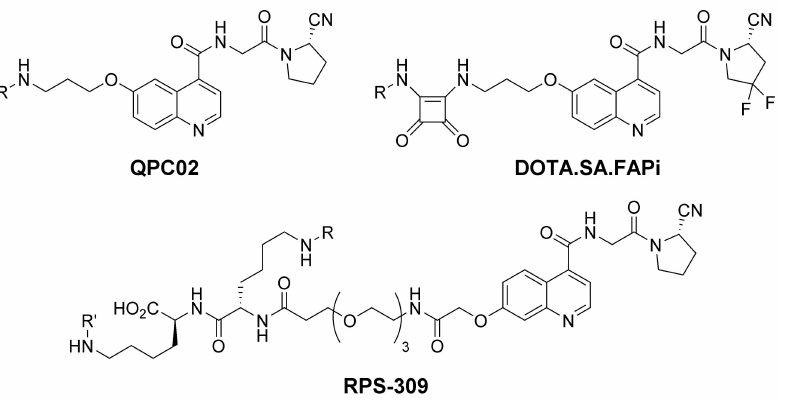
Figure 4. FAP-targeted precursors using a 6- or 7-alkoxy substituted quinoline backbone. R represents the individual chelating moiety. In the case of RPS-309, R (cid:48) represents an albumin binding